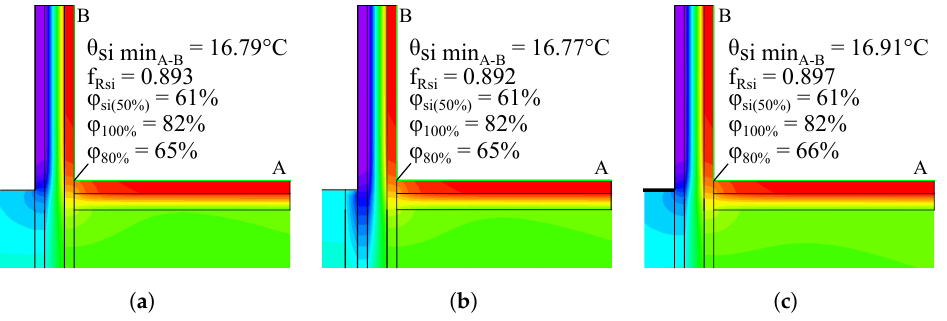
Figure 9. Temperature distribution in the wall and foundation in different arrangements of external insulation layer: ( a ) no external insulation, ( b ) additional vertical insulation and ( c ) additional horizontal